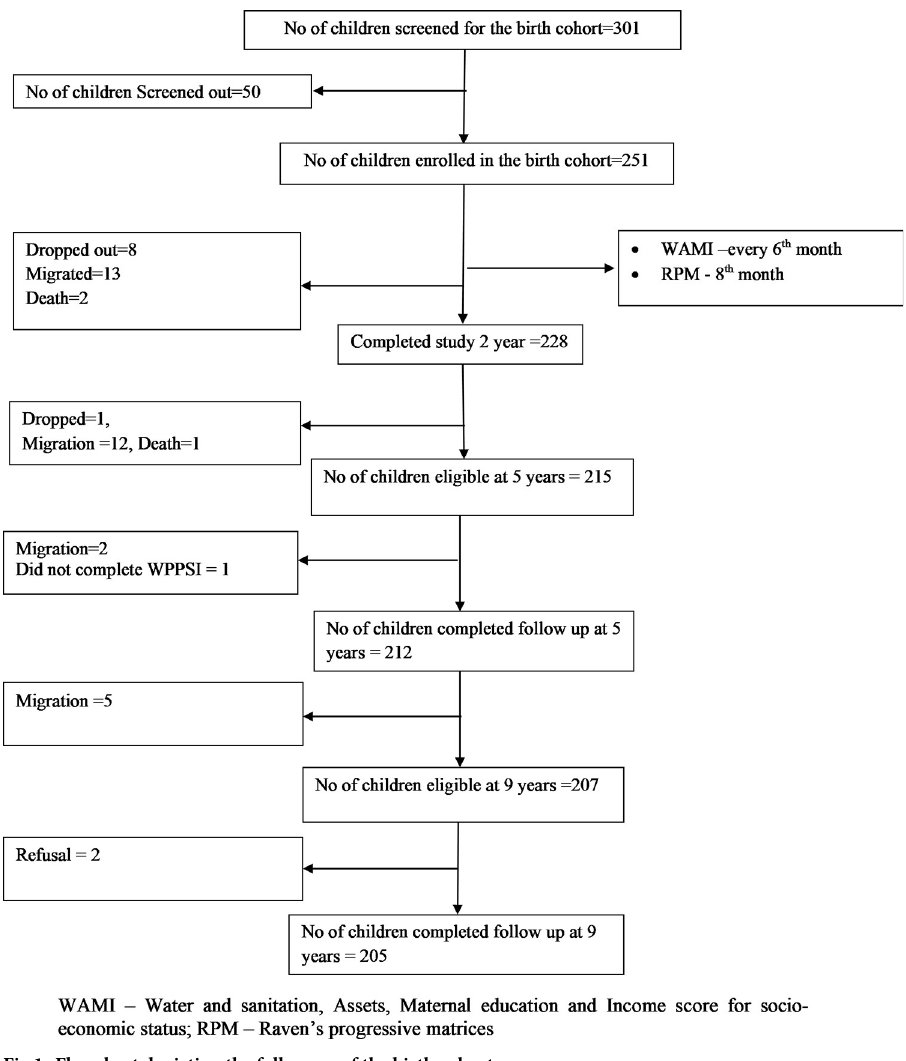
Fig 1. Flowchart depicting the follow-up of the birth